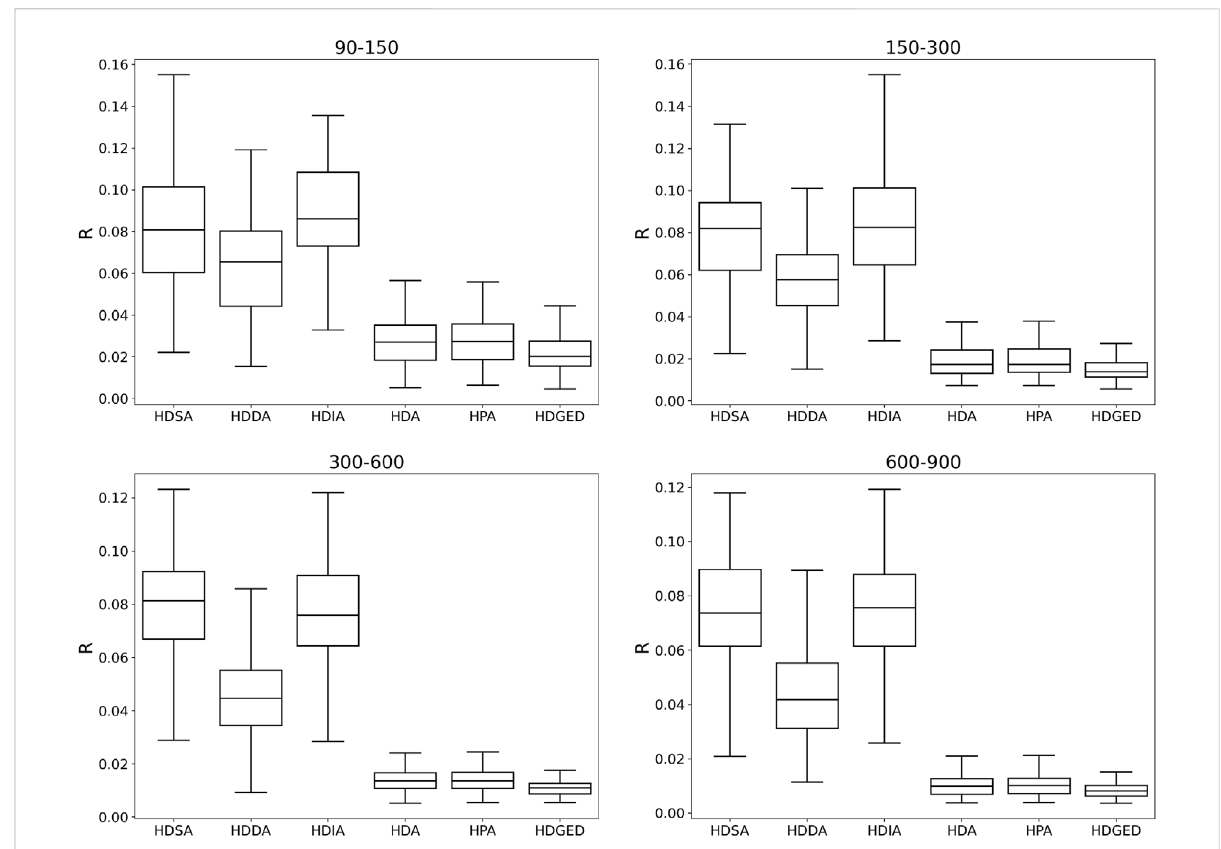
FIGURE 12 Comparison ofdisintegration capabilityofHDGEDandbaselinealgorithmsonscale-freeHCNoffourdifferentscaleswithconsideringthecost of network